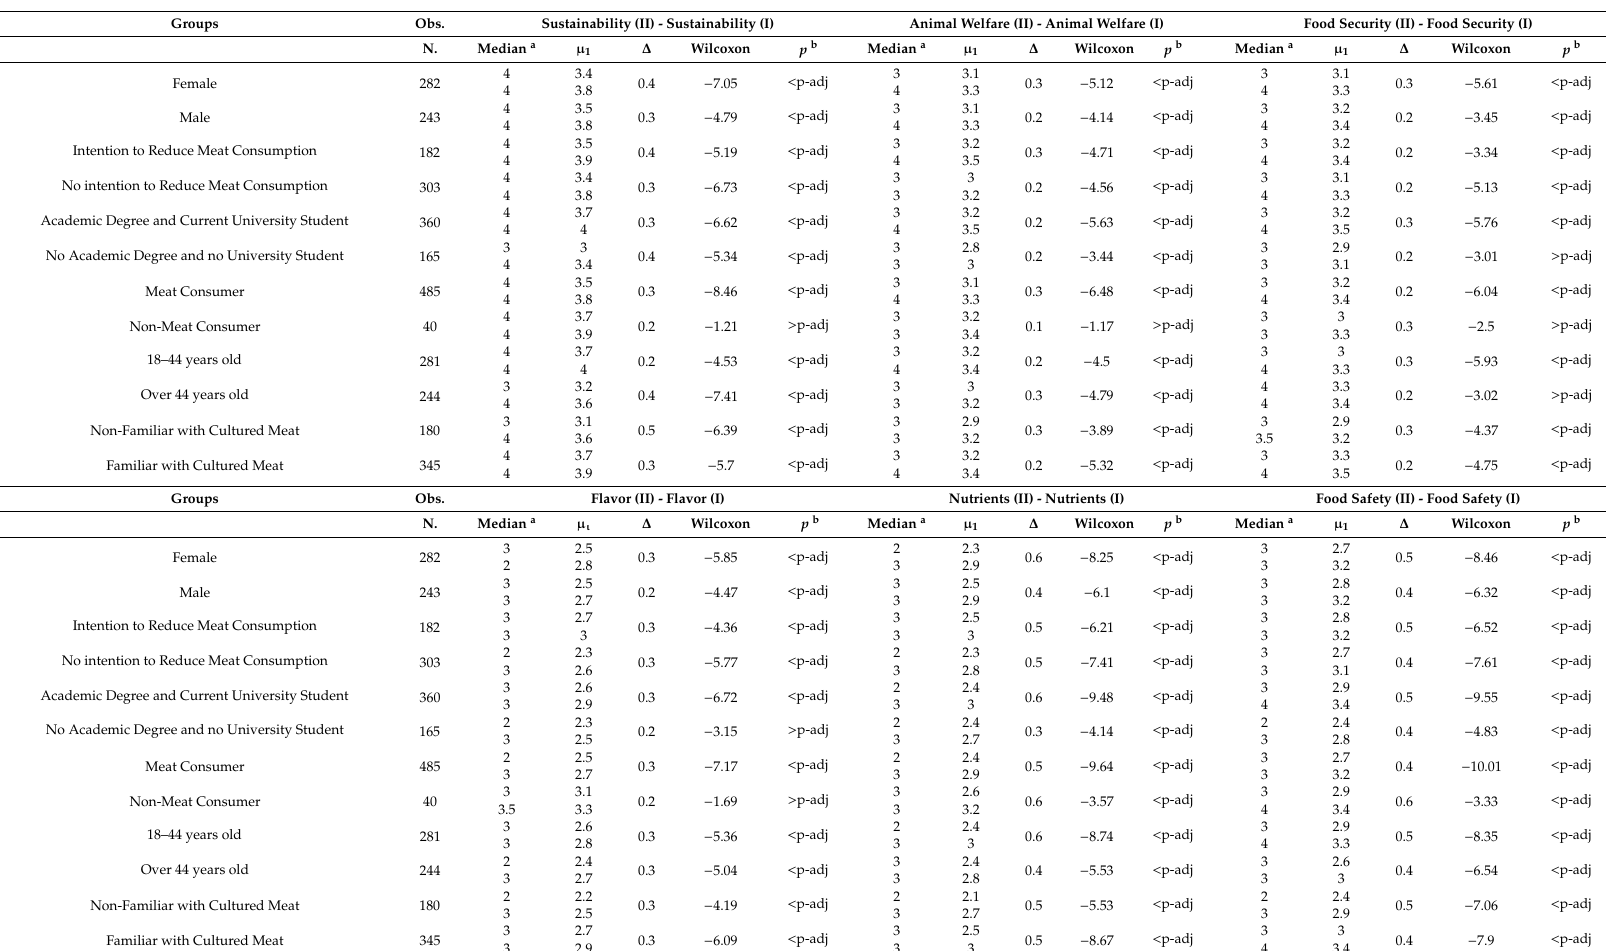
Table 3. Medians, average scores, and significance level of score di ff erences between the level II and the level I of information for beliefs on positive externalities and intrinsic attributes per